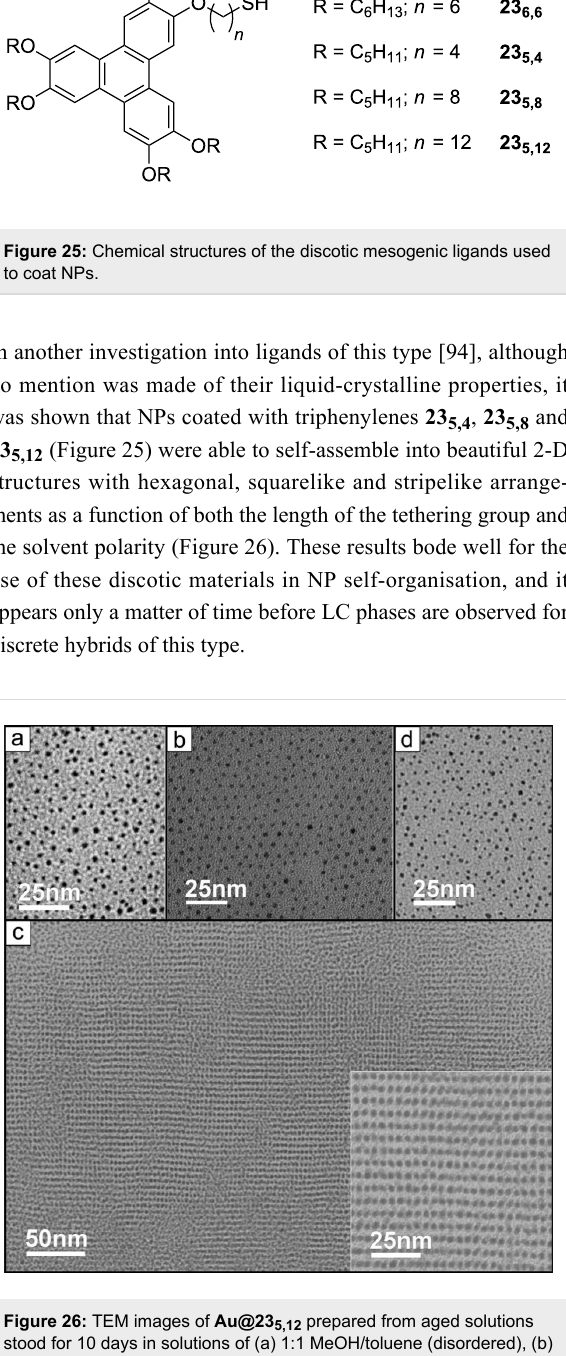
Figure 26: TEM images of Au@23 5,12 prepared from aged solutions stood for 10 days in solutions of (a) 1:1 MeOH/toluene (disordered), (b) 2:1 MeOH/toluene (hcp), (c) 3:1 MeOH/toluene (stripelike; inset is an expansion), (d) 4:1 MeOH toluene (disordered). Reprinted with permis- sion from [94]. Copyright 2007 American Chemical